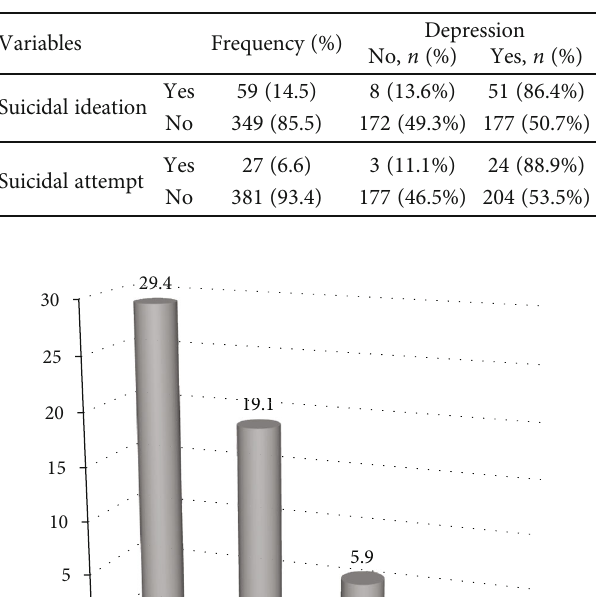
Figure 3: Ever use of substance among prisoners in Mekelle General Prison Center, Tigray, Ethiopia, 2019 ( n = 408 ). Table 4: Suicidal characteristics of prisoners in Mekelle General Prison Center, Tigray, Ethiopia, 2019 ( n = 408 ).